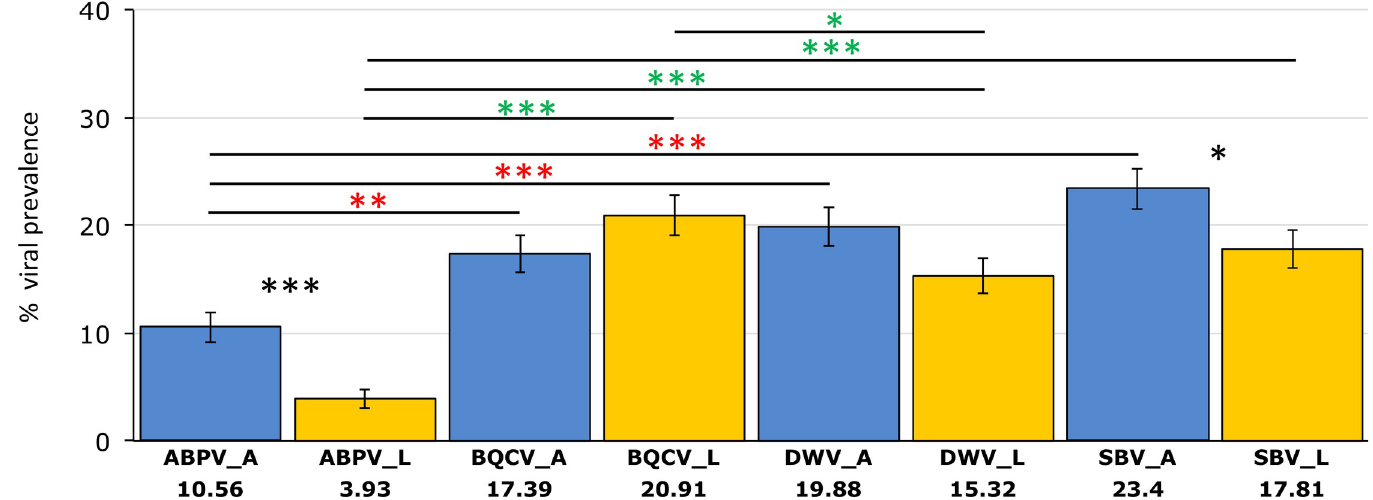
Fig 3. Overall percentages of viral prevalence (y-axis) in adults (A, blue bars) and larvae (L, yellow bars). N = 483. Significant differences in viral prevalence between larvae and adults are represented with black stars. Significant differences in the prevalence of the different viruses in adults and in larvae are represented by red and green starts, respectively (p < 0.05 � , p < 0.001 �� , p < 0.0001 ��� ). Error bars represent SE. Data were analyzed using one-way ANOVA followed by Bonferroni correction.